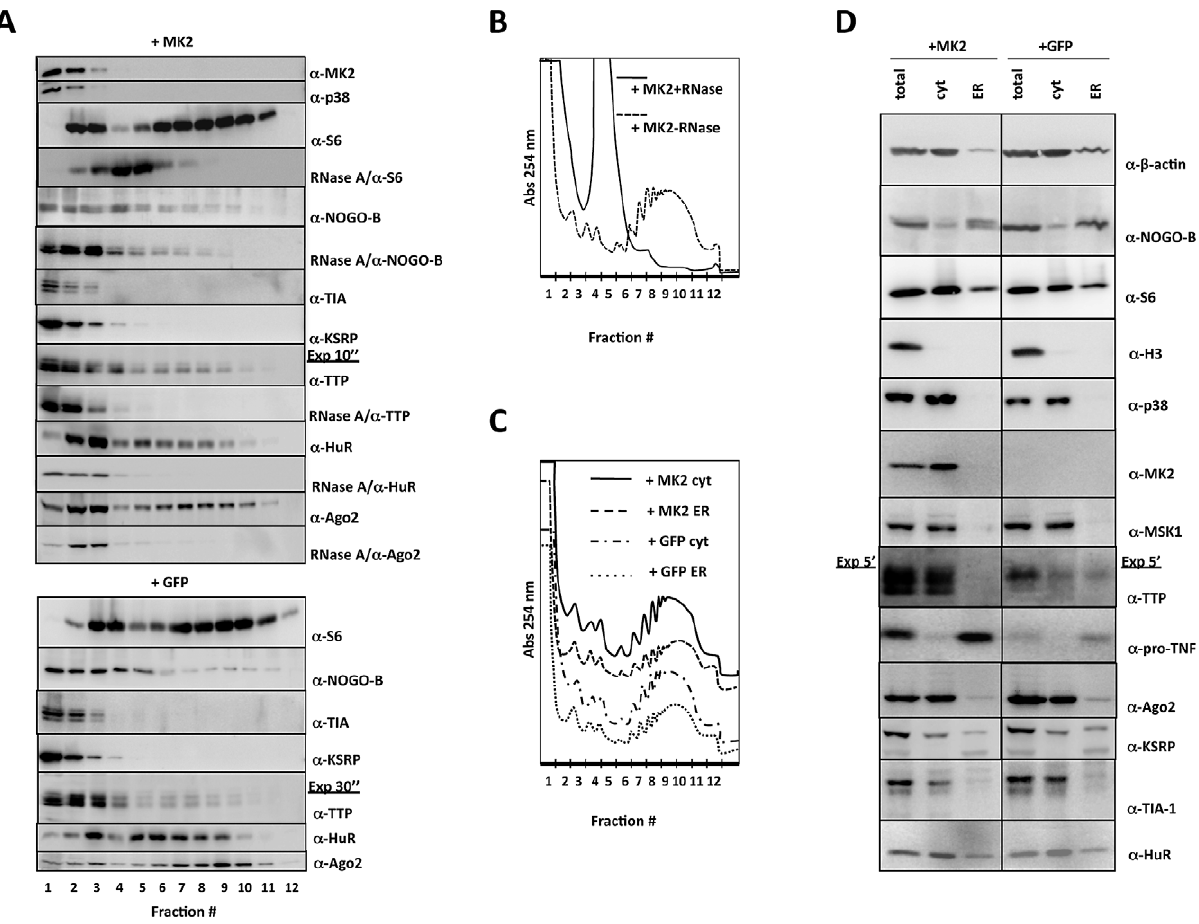
Figure 3. Western blot analysis of protein distribution in polysome profiling and ER/cytosolic sub-fractionation. A) Distribution of relevant proteins in the polysome profile (fractions 1–12) of MK2-rescued ( + MK2) and GFP-transduced ( + GFP) cells. Where indicated an RNaseA treatment was carried out before polysome profiling to monitor requirement of RNA-binding for the distribution. B) Polysome profile of LPS-treated MK2-rescued macrophages before and after RNaseA treatment. C) Polysome profiles of cytosolic and ER subfractions of LPS-treated MK2-rescued and GFP-transduced macrophages. D) Distribution of relevant proteins in the ER and cytosolic (cyt) fraction of MK2-rescued ( + MK2) and GFP-transduced ( + GFP) cells. Total lysate before fractionation (total) is shown as